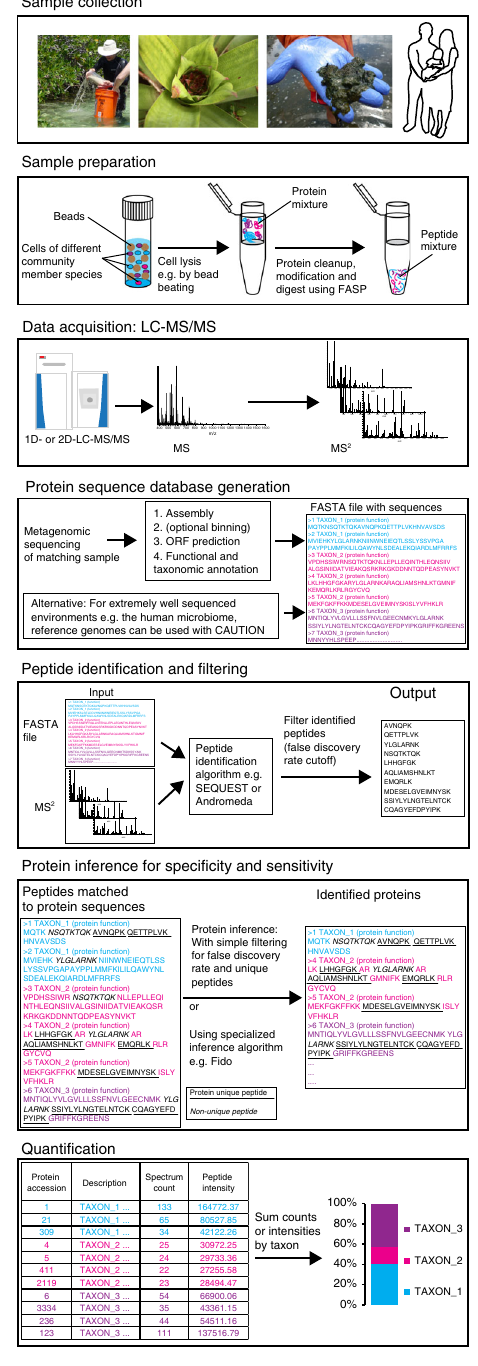
Fig. 1 Work fl ow for assessing species biomass contributions using metaproteomics. The presented work fl ow can be adapted to different LC- MS/MS systems and computational tools. The critical considerations for achievement of high accuracy and sensitivity are as follows: (1) use of a protein sequence database derived from a metagenome of a sample matching to the metaproteomic samples; (2) selection and optimization of protein inference parameters with test datasets to achieve suf fi cient speci fi city; and (3) quanti fi cation of taxa using the sum of PSM counts or peptide intensities based on inferred proteins and not based on peptide